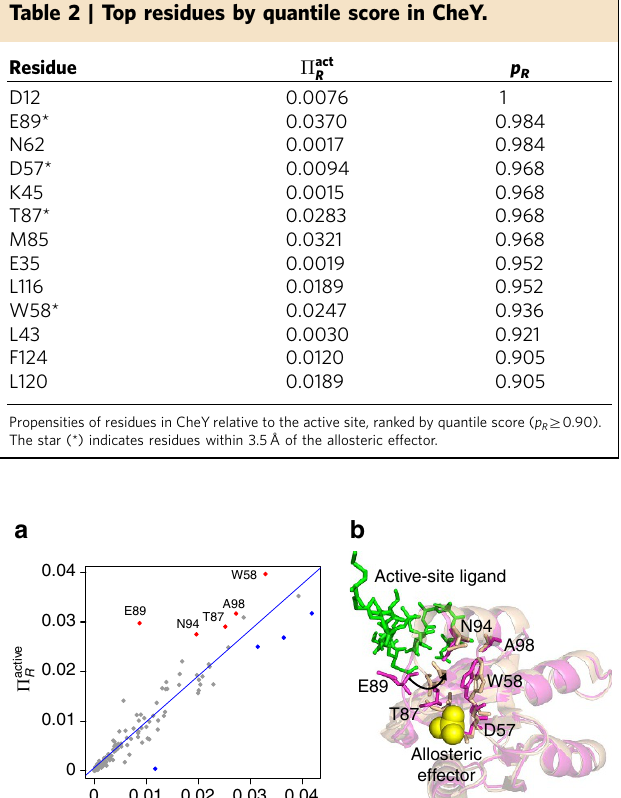
in Supplementary Table 2 and Supplementary Method 1). The profiles of bond-to-bond propensities are similar across all conformations (Supplementary Fig. 2), highlighting the robust- ness of the propensity scores to local dynamical rearrangements across different conformations. In particular, the propensities in the active (1F4V) and inactive (3CHY) conformations show a strong positive correlation ( r ¼ 0.94). Using Cook’s distance, a well-known method to detect influential points in linear regression 46 , we identify E89, N94, T87, A98 and W58 as residues with highly increased propensity in the active conformation as compared with the inactive conformation (Fig. 3a). Superposition of the active and inactive structures shows that the large displacement of E89 causes the formation of a tighter network of interactions involving N94, T87 and W58 in the active conformation (Fig. 3b). Interestingly, the propensity of the allosteric phosphorylation site D57 is similar in the active and inactive conformations; in the inactive conformation, D57 forms a strong hydrogen bond with K109, yet the weakening of this bond in the active conformation is compensated for by the formation of the network involving W58 and E89. Hence activation induces a structural rearrangement of the network of bonds that connect the phosphorylation site to the active site. Variability in NMR ensembles uncovers transient effects . CheY exists in dynamic equilibrium between its active and inactive NATURE COMMUNICATIONS|7:12477|DOI: